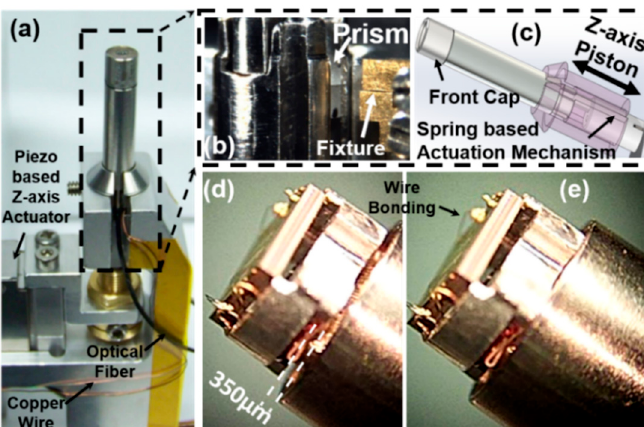
Figure 8. Integration of the 2D resonant MEMS scanner in the miniaturized fiber-based intraoperative NIR fluorescence confocal microscope. ( a ) Stereomicroscopic image of the microscope; a piezoelectrical Z -axis actuator (P-601.4SL) was used for axial scanning (DC stacking mode, or axial scanning up to 5 Hz with a 350- µ m range); ( b ) zoom-in view of the microscope’s distal end; Risley prisms were used for aligning the beams precisely to be parallel; additional metal alignment fixtures; ( c ) schematic drawing of the scan-head’s distal end and the spring-based Z -axis piston mode actuation mechanism; ( d , e ) zoom-in view of the Z -axis movement of the MEMS scanner holder stage with 350- µ m movement; the front cap has been taken off.